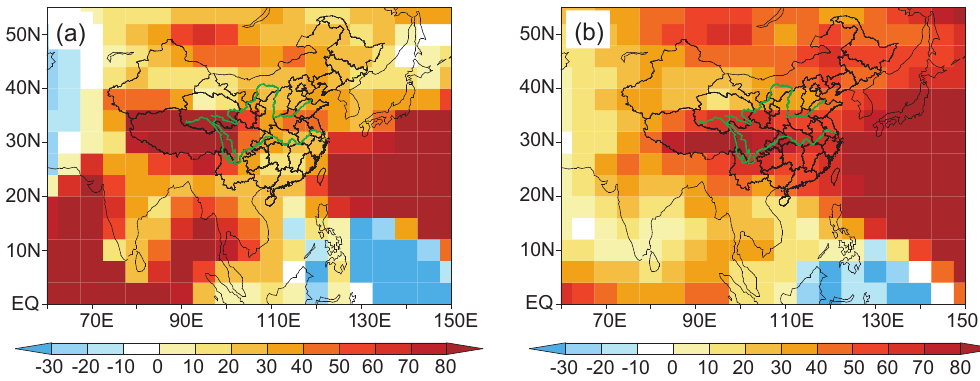
Fig. 3. Percentage changes in (a) Surface-layer OC (µgm − 3 ) and (b) Column burden of OC mgm − 2 in 1998 relative to 2002.